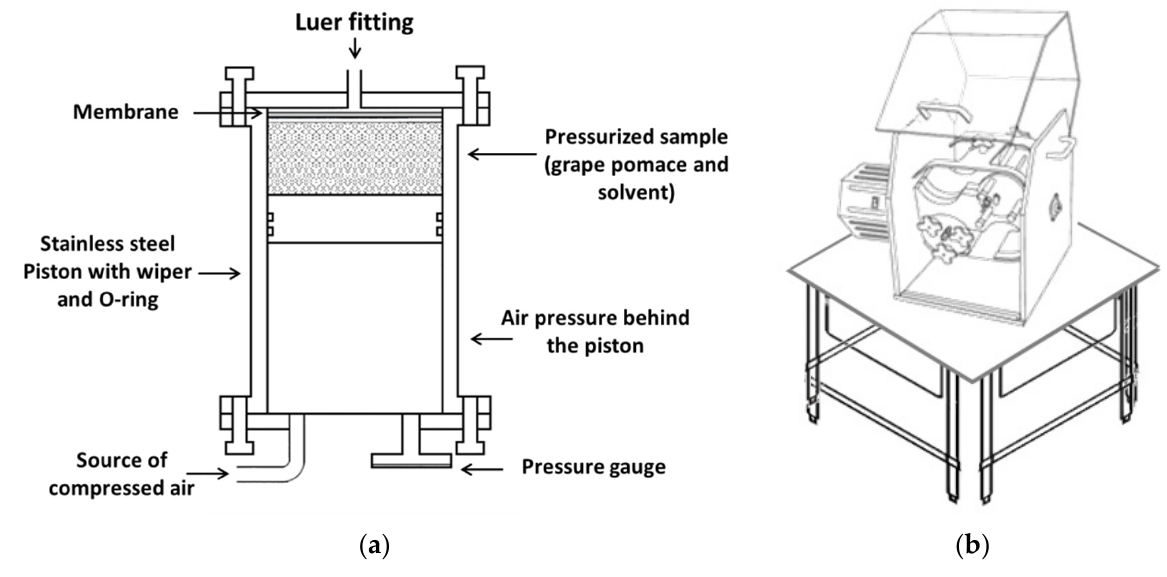
Figure 2. Diagram of Zero Headspace Extractor “ZHE” ( a ); rotary agitation device ( b ).